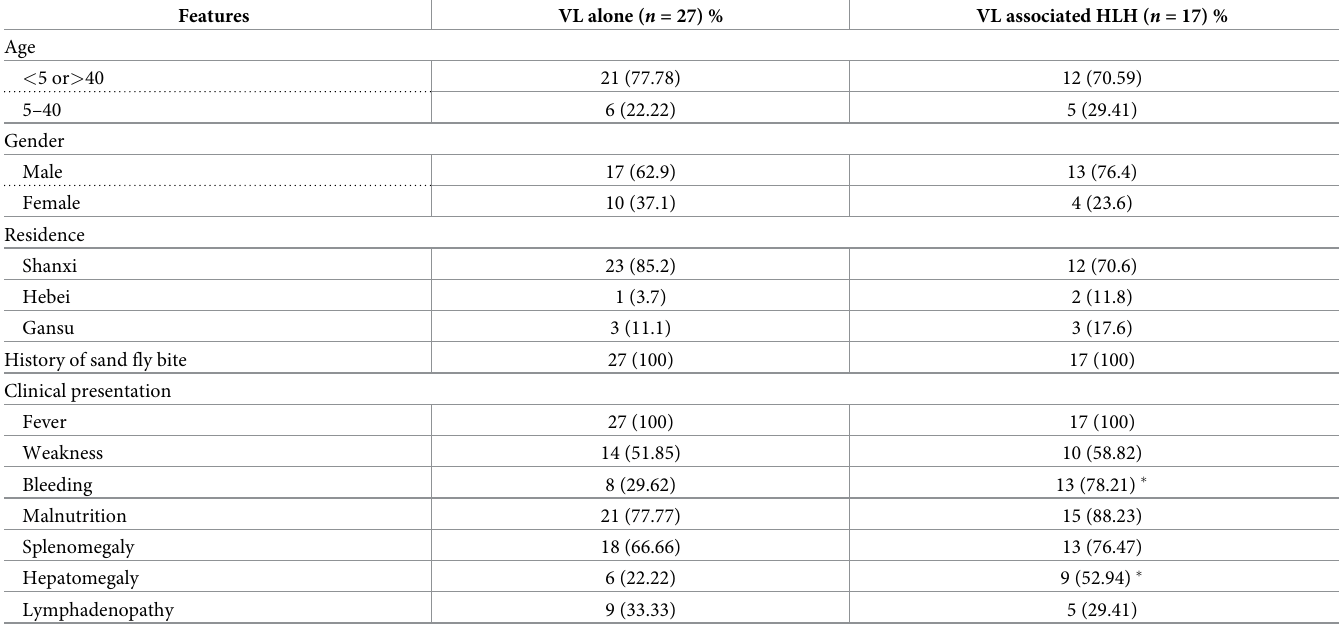
Table 2. Comparison of demographic and clinical presentation of VL patients with or without HLH.